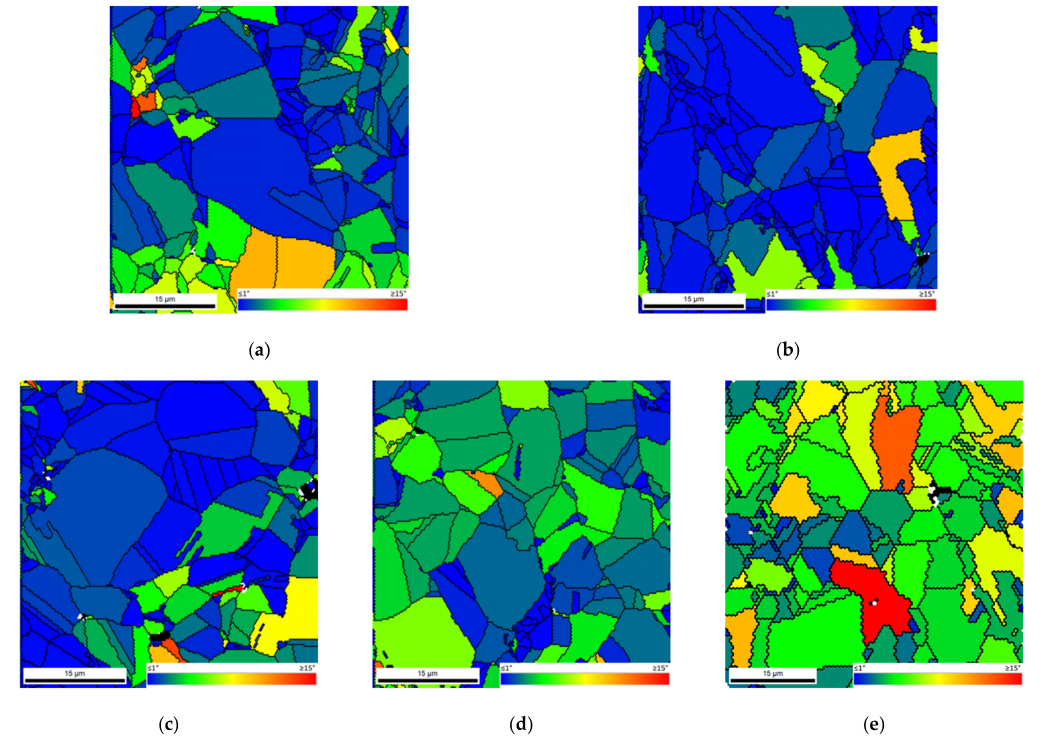
Figure 13. GOS maps of Ni produced by ball milling for ( a ) 60, and ( b ) 300 min and of Ni-CNT produced with ( c ) 60, ( d ) 180, and ( e ) 300 min of ball